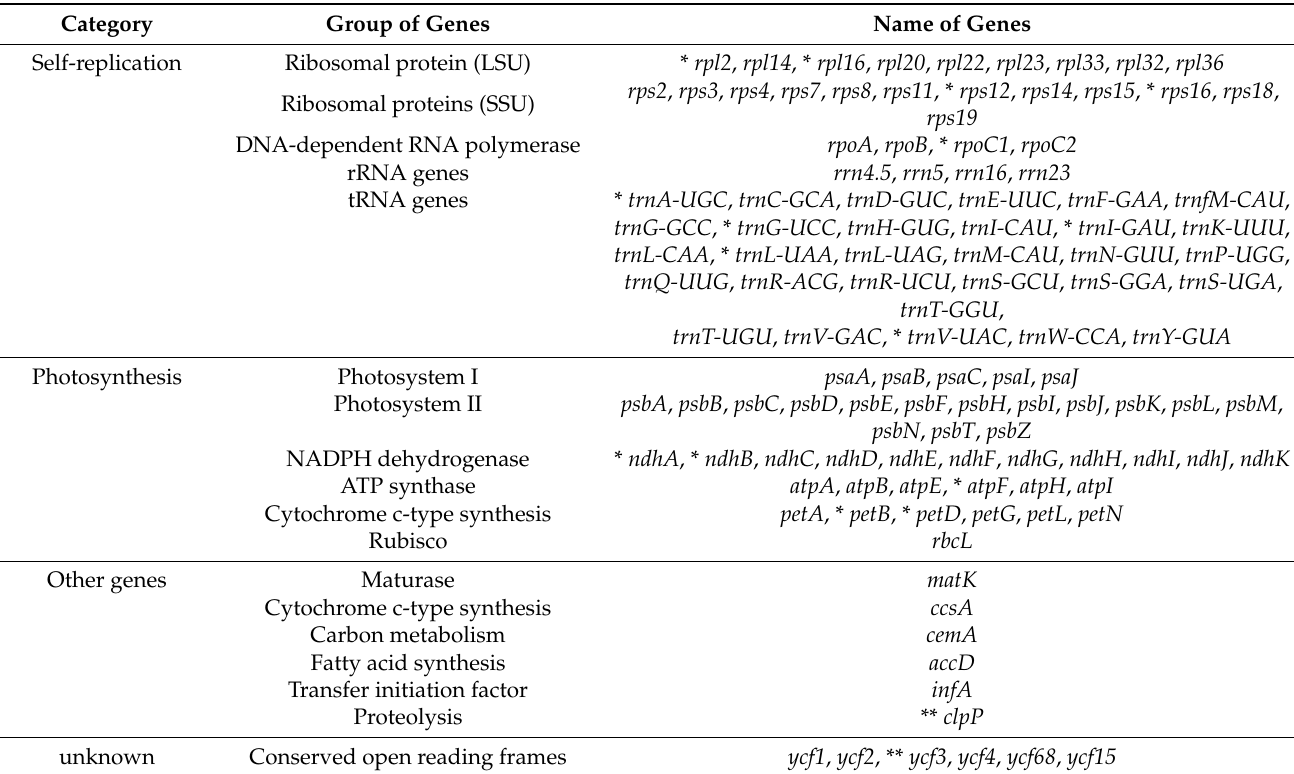
Table 2. Genes present and functional gene category in F. venosa chloroplast